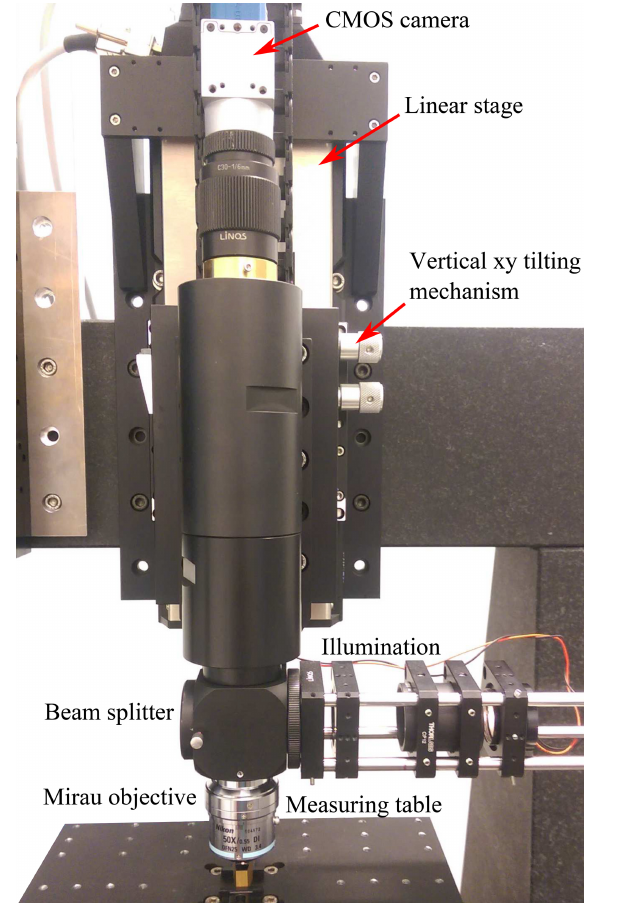
Figure 2. Self-assembled Mirau interferometer measuring a chirp standard provided by Physikalisch-Technische Bundesanstalt